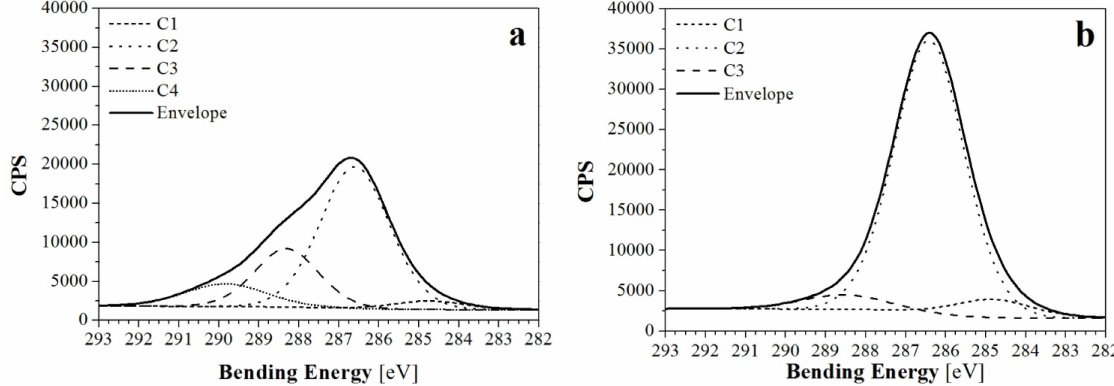
Figure 7. Deconvoluted curves of XPS C1s peaks of ( a ) NW C-Cr1010; and ( b ) NW C-Cr1010-Et10 samples. CPS stands for counts per second as a measure of the